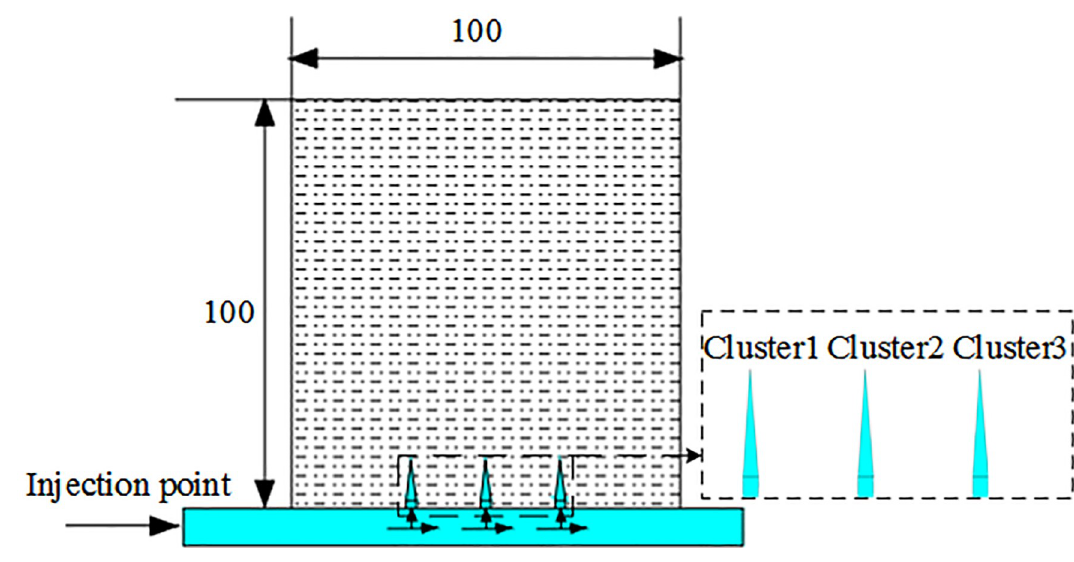
Fig 6. Two-dimensional calculation model.